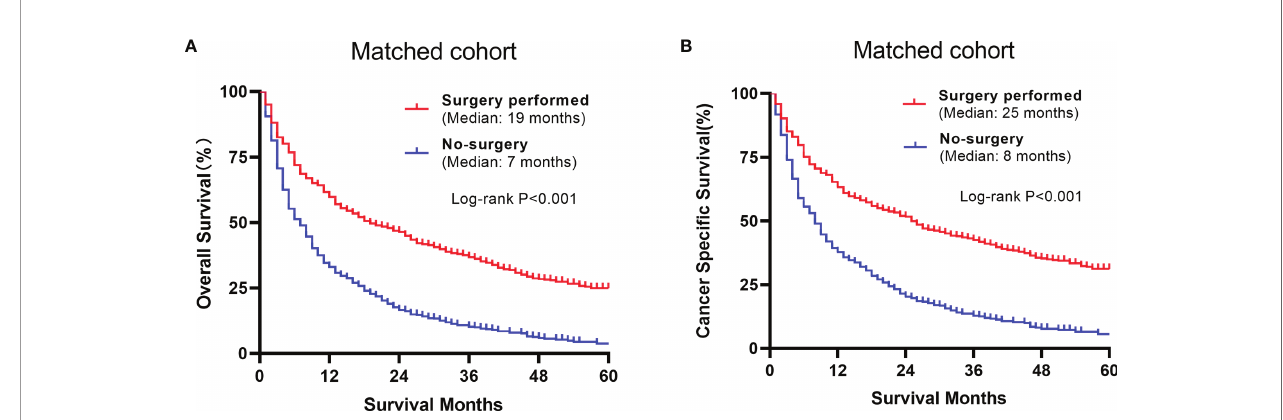
FIGURE 5 | Comparison between the surgery and non-surgery groups of the matched group (A) Overall survival of the 2 matched groups (B) Cancer speci fi c survival plots of the matched